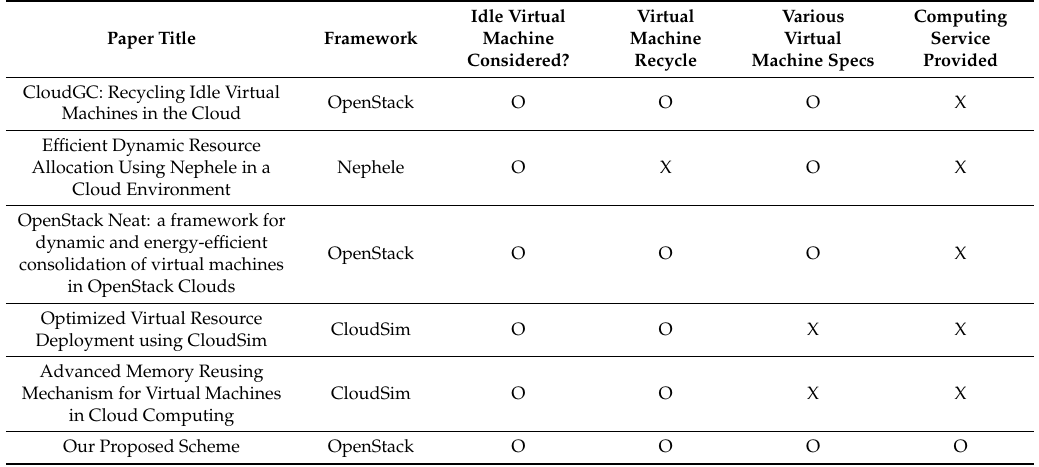
Table 1. Comparison of the idle virtual machine–resource utilization (IVM–ReU) with previous studies. Paper Title